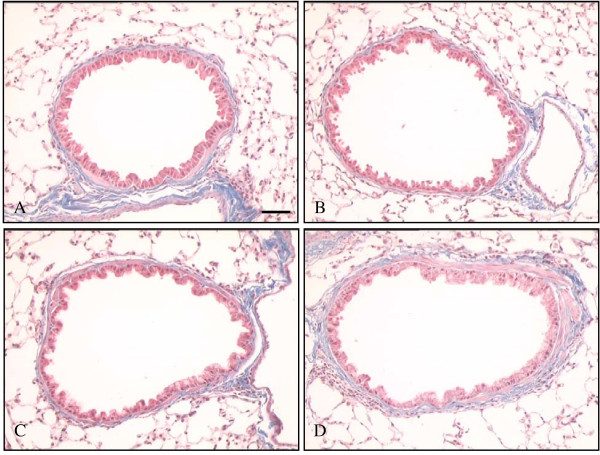
Increased sub-epithelial collagen deposition in the airways of ovalbumin sensitised and challenged mice. MSB staining of representative airways from each treatment group at 12 days after final challenge. (A) saline sensitisation/saline challenge (B) saline sensitisation/ovalbumin challenge (C) ovalbumin sensitisation/saline challenge (D) ovalbumin sensitisation/ovalbumin challenge. Increased blue-staining sub-epithelial collagen is seen in the ovalbumin sensitised/challenged airway compared with the three controls, which have similar appearances. Scale bar represents 50 μm.